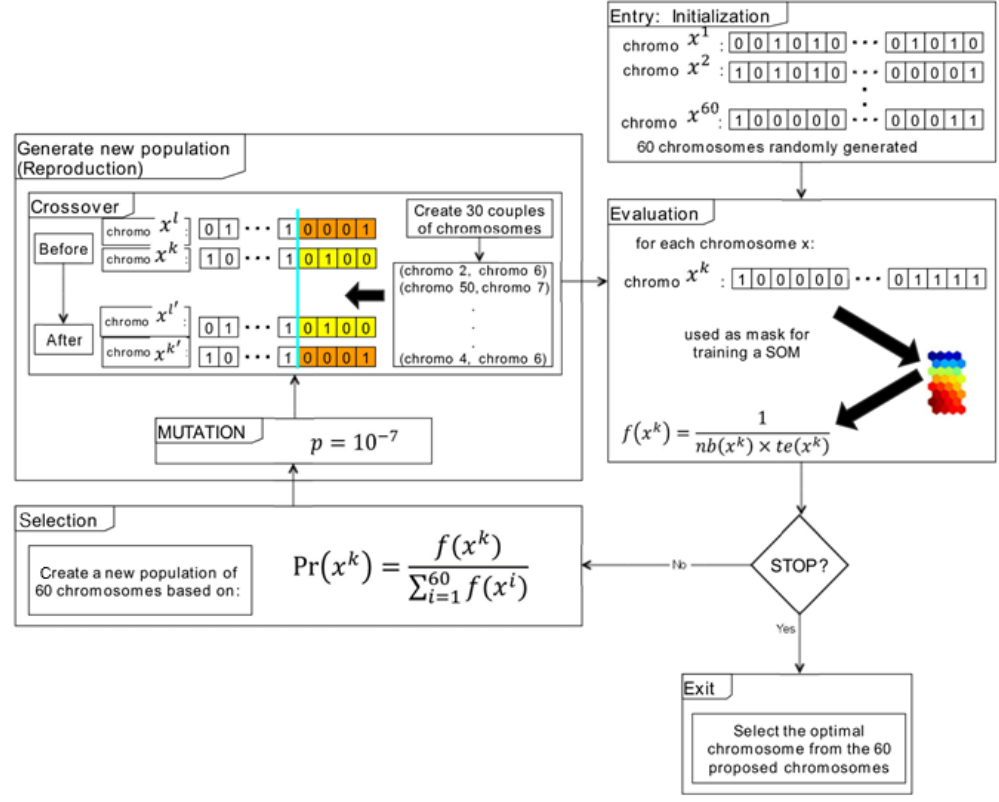
Figure 2. Diagram for the selection of variables based on a genetic algorithm associated with Kohonen